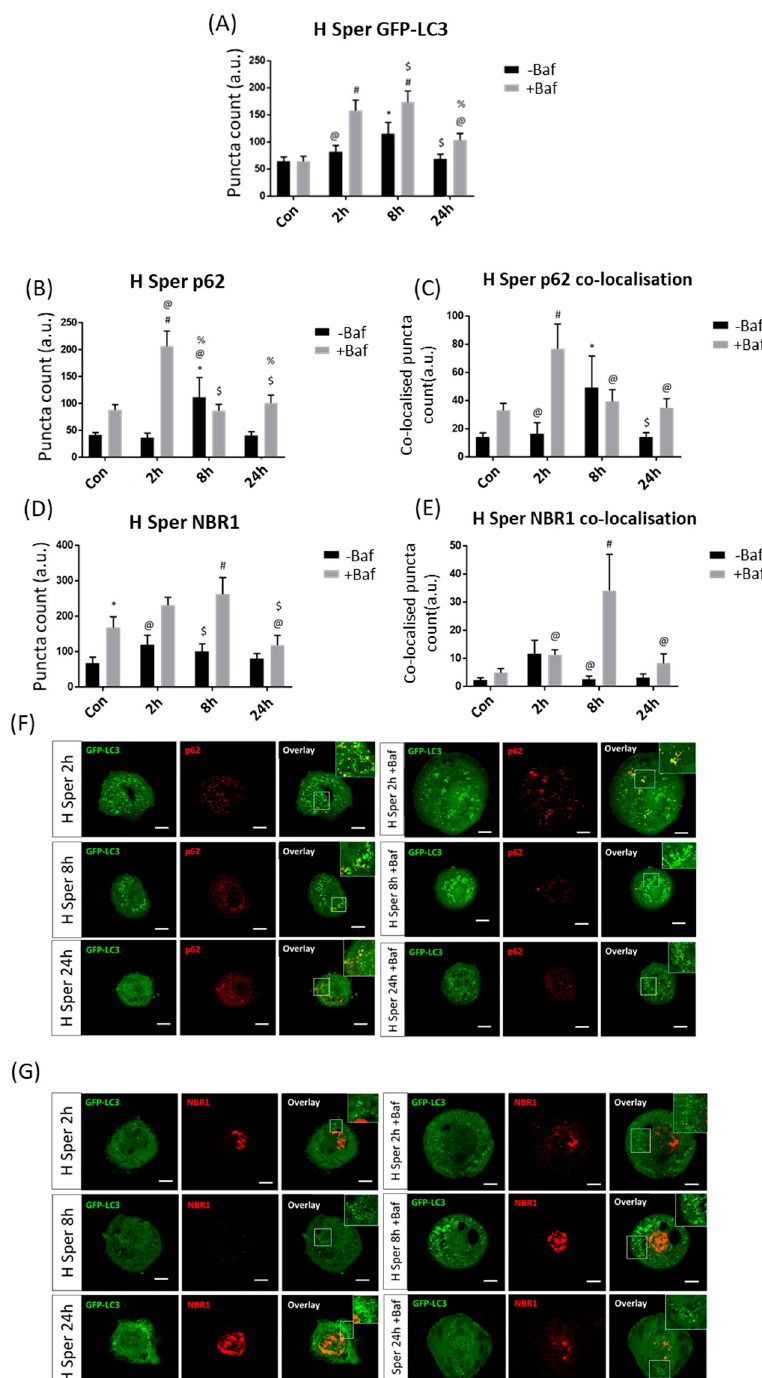
Figure 5. Puncta count analysis following 20 µM spermidine (H Sper) over 24 h in the presence (+Baf) and absence ( − Baf) of bafilomycin. ( A ) Total GFP-LC3 puncta analysis. N = 24. * p < 0.05 vs. Con, # p < 0.05 vs. Con +Baf, @ p < 0.05 vs. 2 h +Baf, $ p < 0.05 vs. 8 h − Baf, % p < 0.05 vs. 8 h +Baf. ( B ) Total p62 puncta analysis. N = 12. * p < 0.05 vs. Con, # p < 0.05 Con +Baf, @ p < 0.05 vs. 2 h −